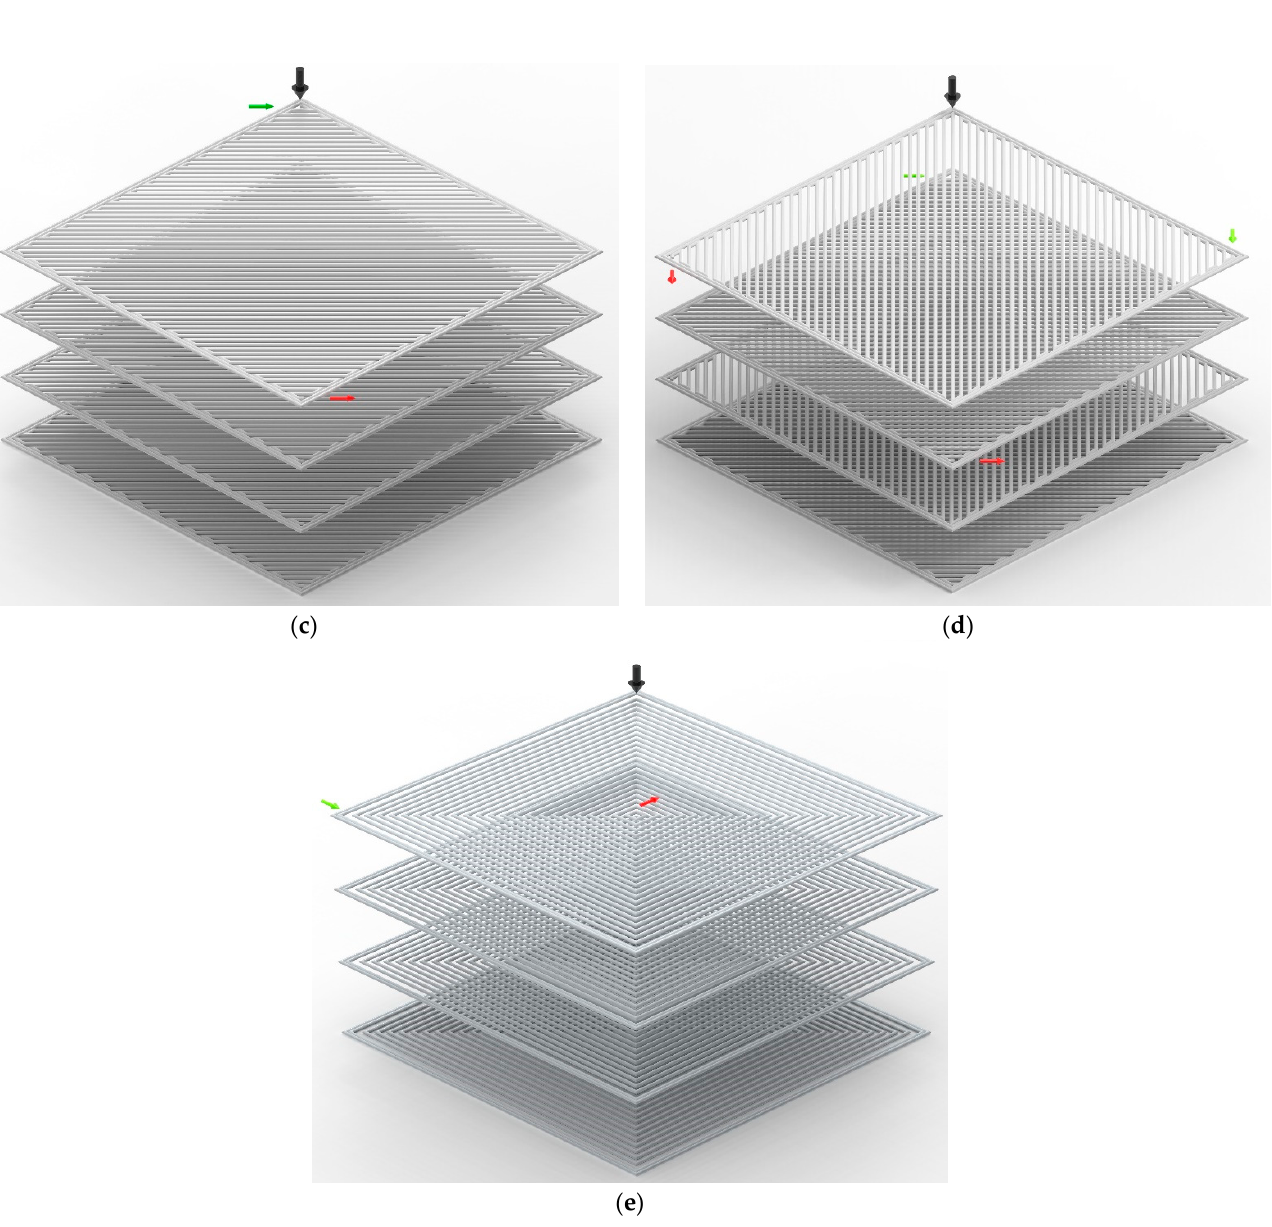
Figure 4. FDM raster patterns considered in this study along with their initial and final deposition position. ( a ) Sample a-Rs (90°/90°), ( b ) Sample b-L (0°/90°), ( c ) Sample c-Z (45°/45°), ( d ) Sample d-Z (45°/ − 45°), and ( e ) Sample e-Con. The raster patterns presented here are only a representation of the actual printed FDM patterns. Here, the black arrow represents the location of element m , the green arrow denotes the initial direction of the respective print while the red arrow shows the direction the print terminates for that respective layer.